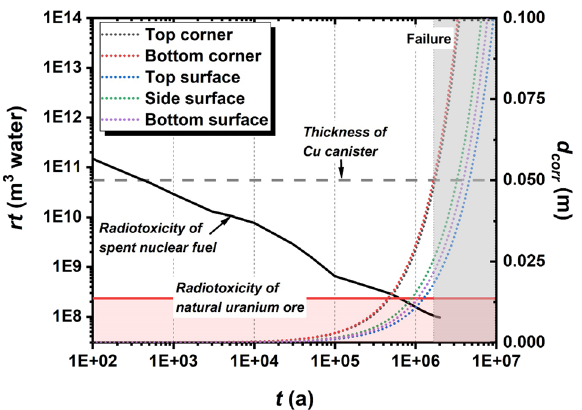
Fig. 16 Corrosion depth and radiotoxicity change with time. Cu corrosion depth ( d corr ) and radiotoxicity (rt) of spent nuclear fuel (PWR) containing 55,000 MWD/MTU (4.5 wt.%) 62 . Fig. 17 Pourbaix (Eh